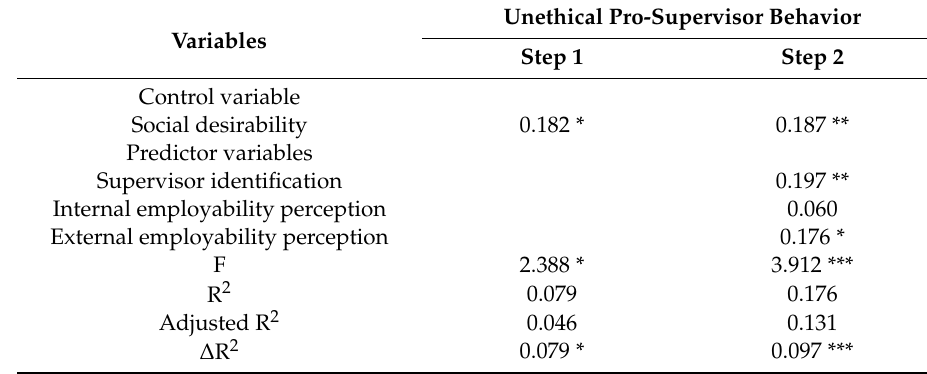
Table 3. Hierarchical regression results.